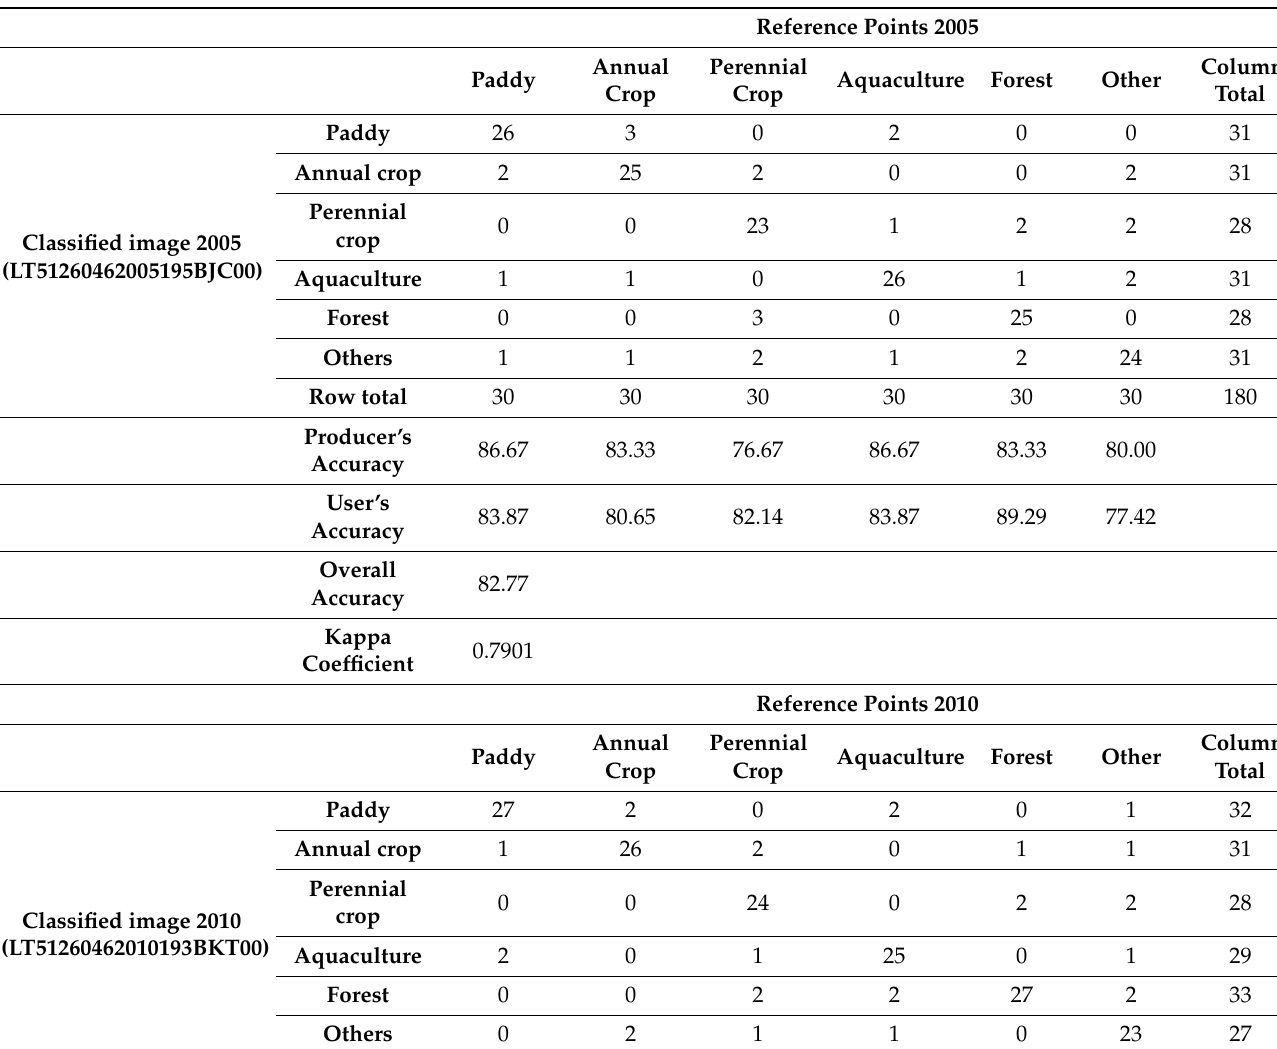
Table 1. Accuracy assessment for land-use map in 2005, 2010, 2015, and